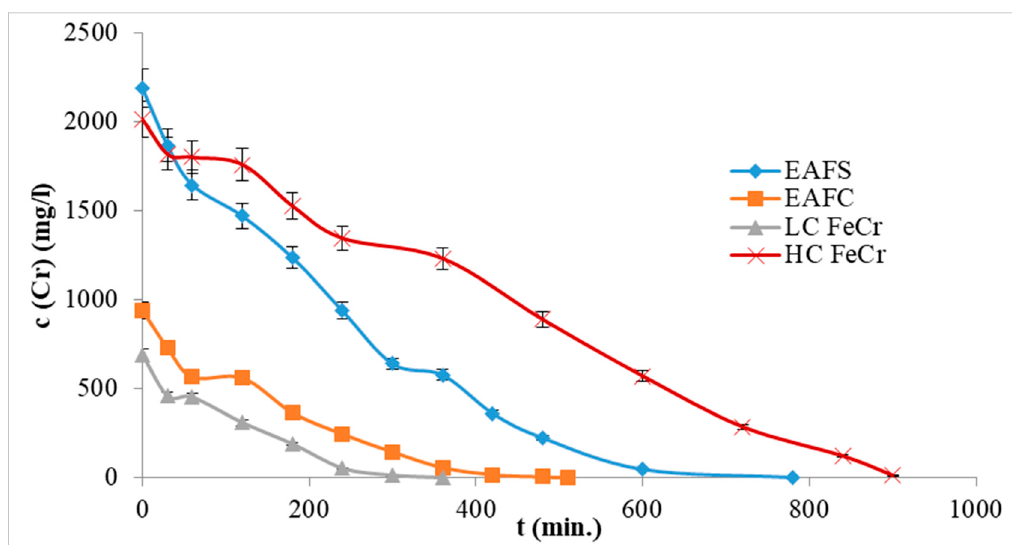
Figure 6. Time dependence of EC process on Cr concentration for real leachates of slags EAFS, EAFC, LC FeCr, HC FeCr, I = 0.1 A, pH = 6.